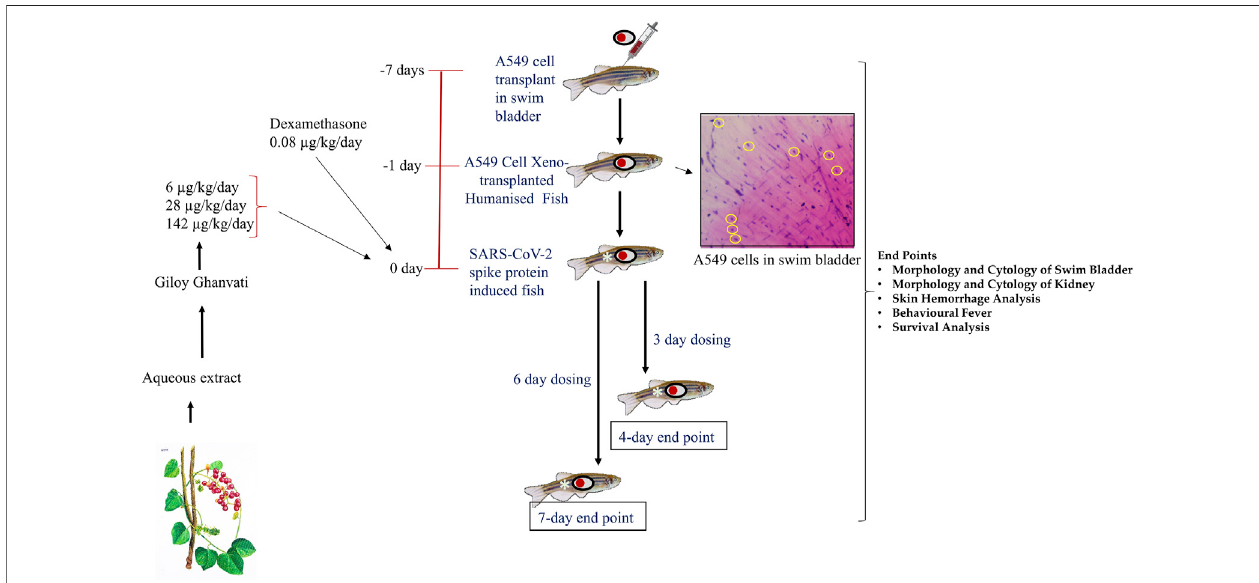
FIGURE 1 | Schematic representing the study design depicting timeline for xenotransplantation, induction with spike-protein of SARS-CoV-2 and treatment with GiloyGhanvati(GG)andDexamethasoneasareferencedrug.Theinsetshowsthehematoxylin-eosinstainingofswimbladdercytologicalsmear.ThetransplantedA549 cells are highlighted in yellow